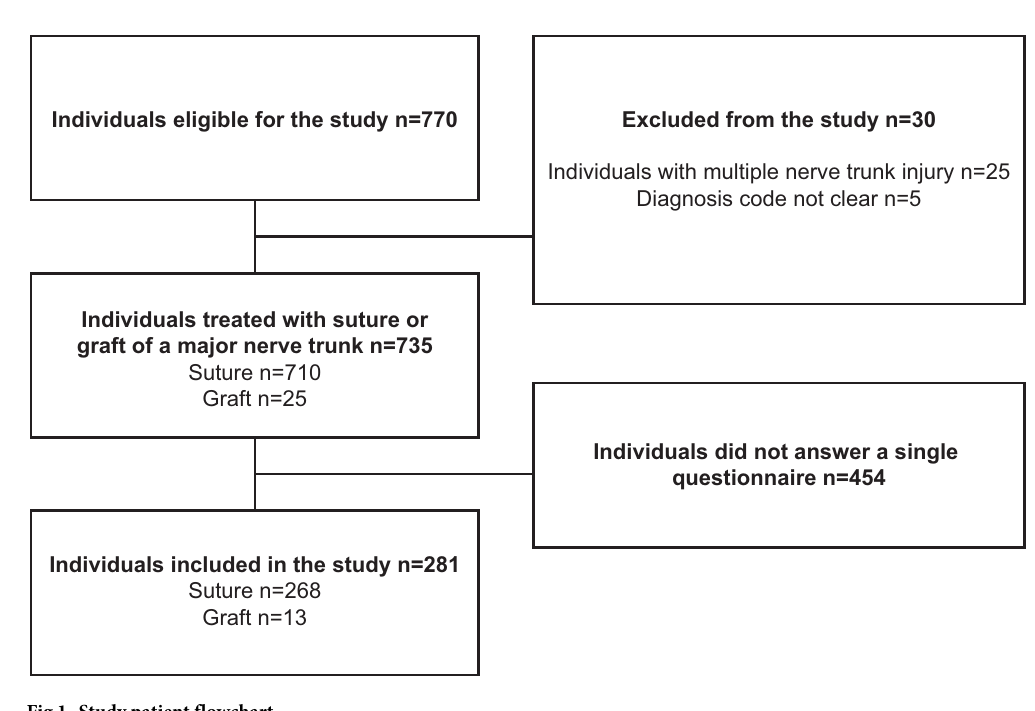
Fig 1. Study patient flowchart.